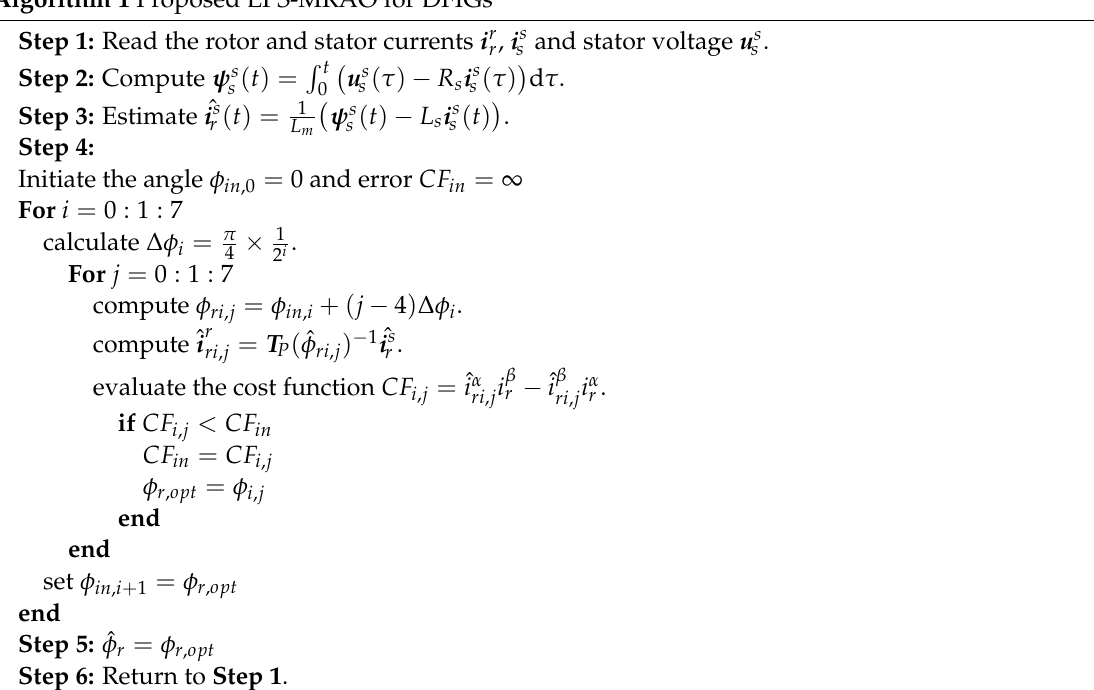
Algorithm 1 Proposed LPS-MRAO for